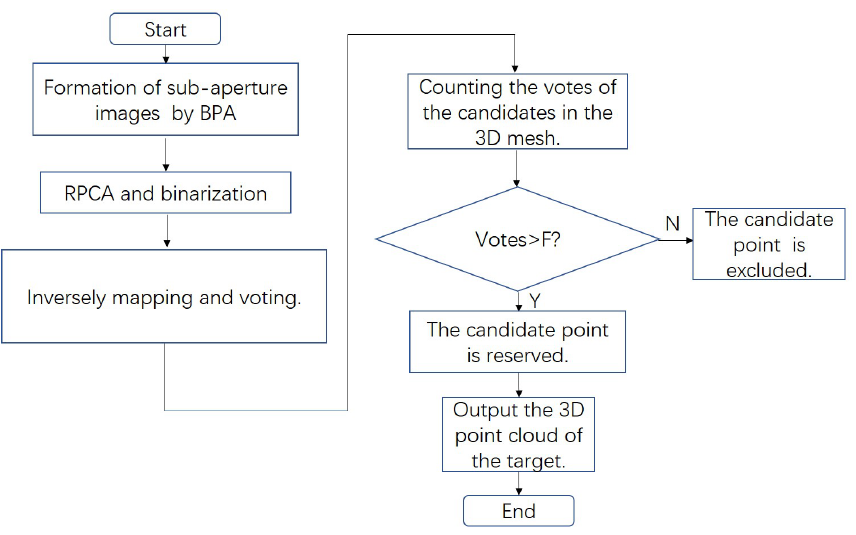
Figure 4. The algorithm flow chart of the proposed